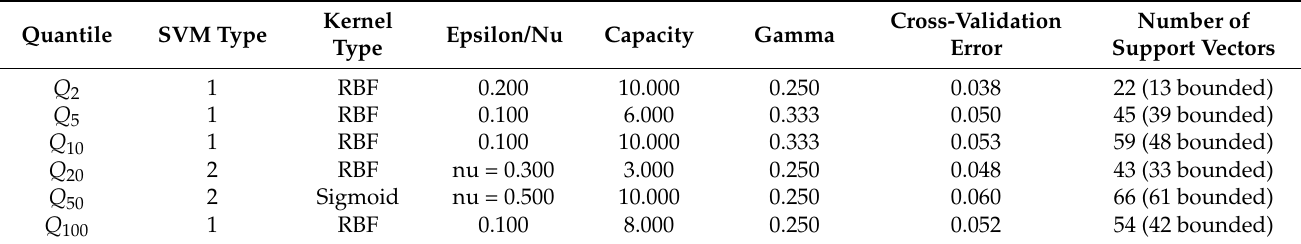
Table A2. Structures of the best-performing SVM models for different flood quantiles.